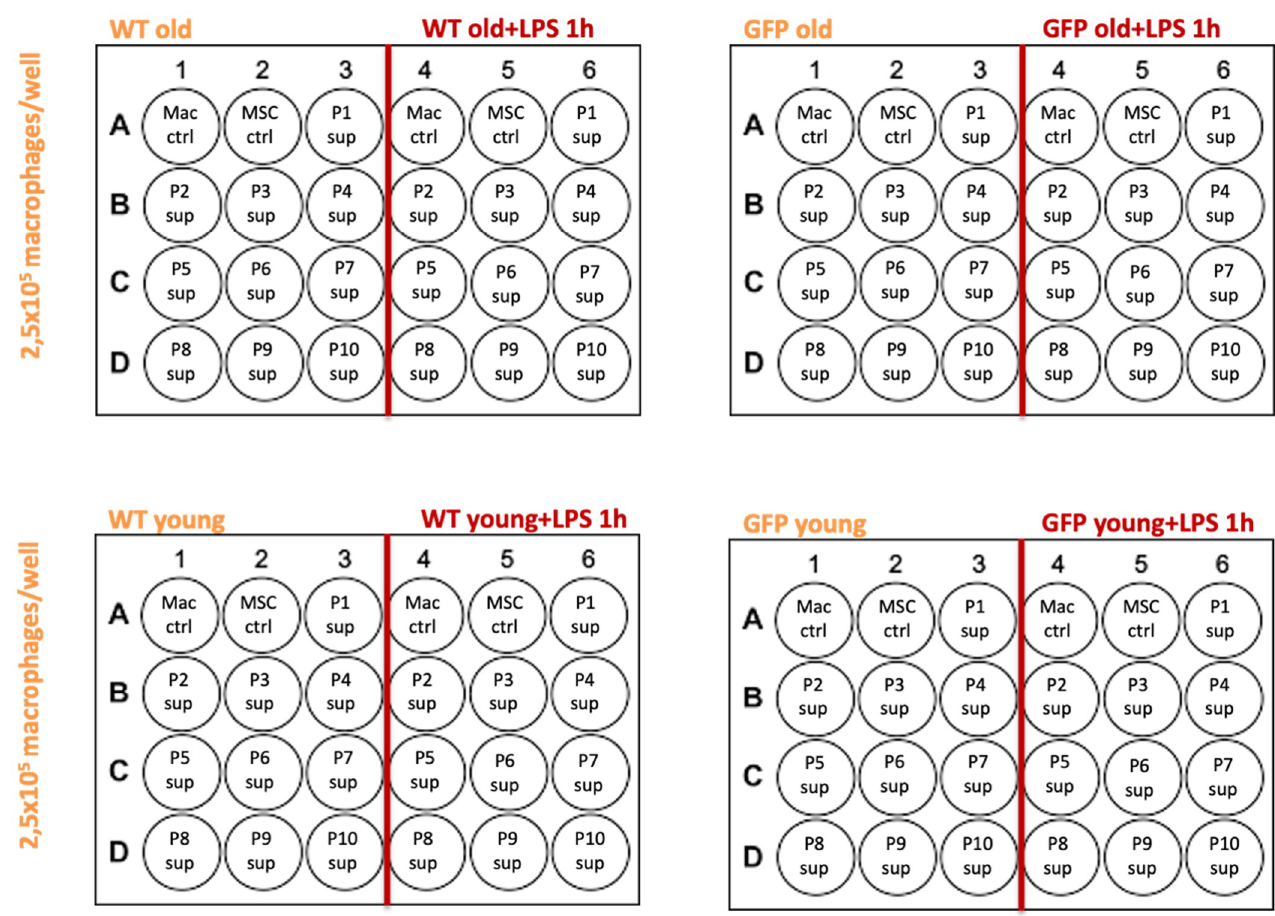
Figure A4. Scheme of in vitro supernatant transfer experiment. The experimental scheme of different in vitro treatments of BMDMs with different supernatants coming from MSCs is illustrated in the Figure. WT old = Wildtype Wistar Kyoto rat >6 months of age as a Mesenchymal Stromal Cell (MSC) donor. WT young = Wildtype Wistar Kyoto rat <6 months of age as MSC donor. LPS = lipopolysaccharide treatment. GFP old = transgenic Wistar Kyoto rat positive for ubiquitous expression of green fluorescent protein (GFP) >6 months of age as MSC donor. GFP young= transgenic Wistar Kyoto rat positive for ubiquitous expression of green fluorescent protein (GFP) <6 months of age as MSC donor. Mac ctrl= untreated macrophages in DMEM based medium as control. MSC ctrl = macrophage in DMEM based medium, treated with blank MSC medium. P1-P10 = passage 1–10; sup =